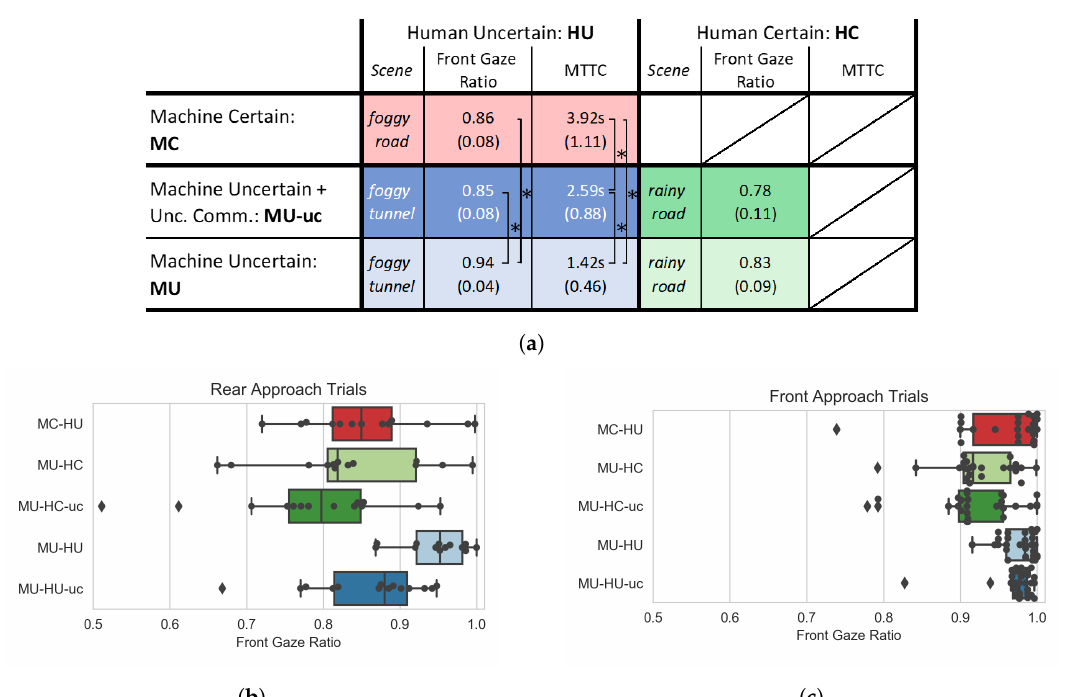
Figure 11. Results of objective measures for different conditions. Conditions are visually represented by distinct colors. For machine uncertain conditions (blue and green), the light colors mark conditions without uncertainty communication. Their dark counterparts indicate uncertainty communication. ( a ) Mean front gaze ratios and MTTC scores for each applicable condition. Standard deviations are shown in brackets. Asterisks indicate statistically significant differences between conditions linked by brackets; ( b ) Gaze ratio for conditions in which the machine was uncertain and for trials in which vehicles were approaching from the rear. Lower values indicate more gazing towards the mirrors. Due to failed eye tracking recordings, n = 13 (instead of 14) for all conditions; ( c ) Gaze ratio for conditions in which the machine was uncertain and for trials in which vehicles were approaching from the